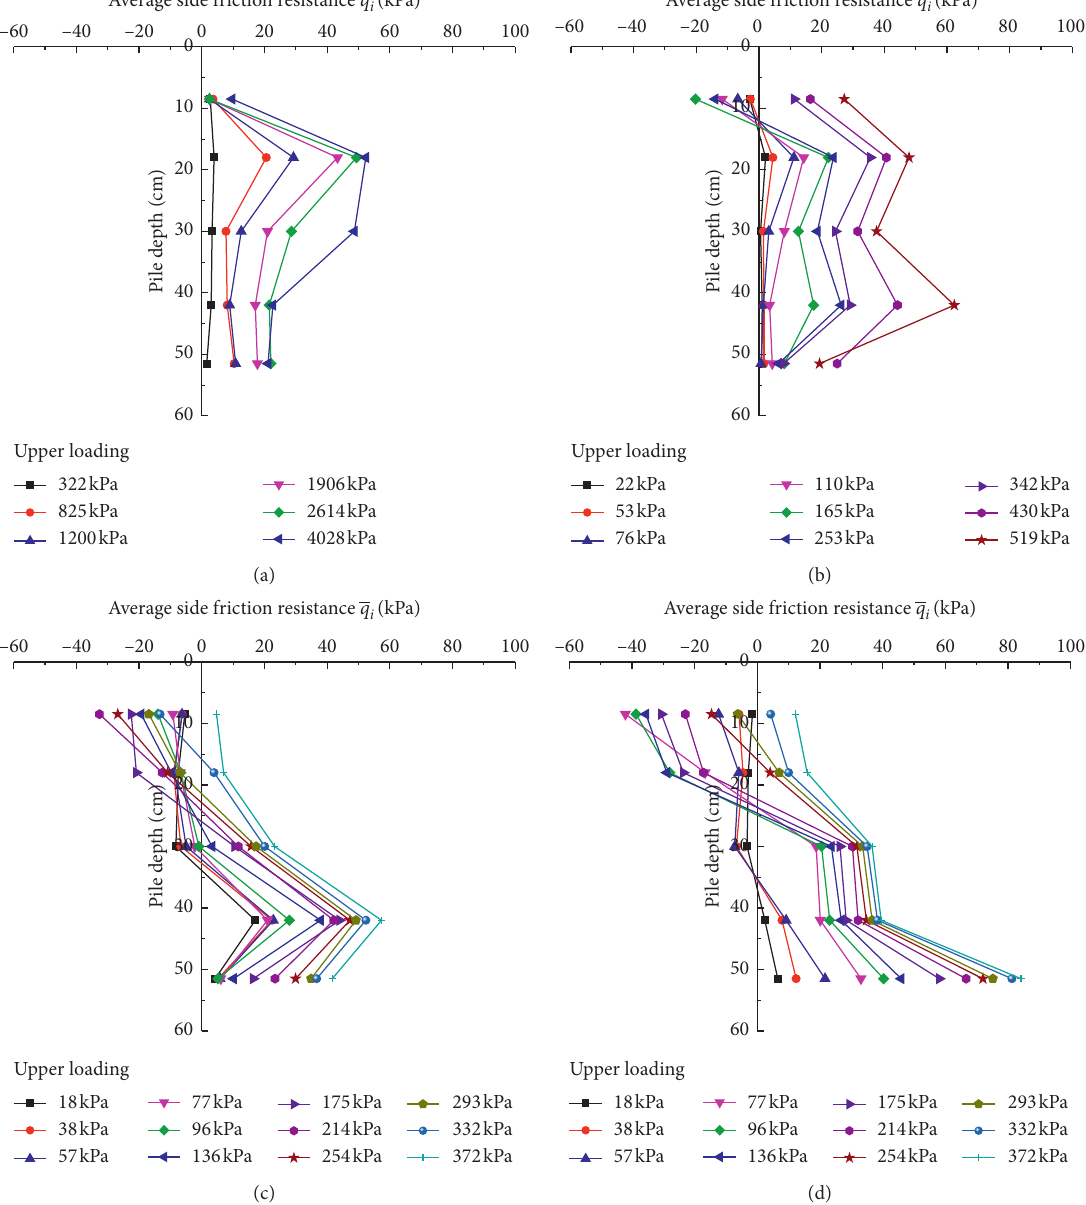
Figure 7: Variations of side friction resistance with change of depth and upper load in the different model test. (a) Y-1 single pile, (b) Y-2 single pile composite foundation, (c) Y-3 group pile composite foundation (middle pile), and (d) Y-3 group pile composite foundation (side